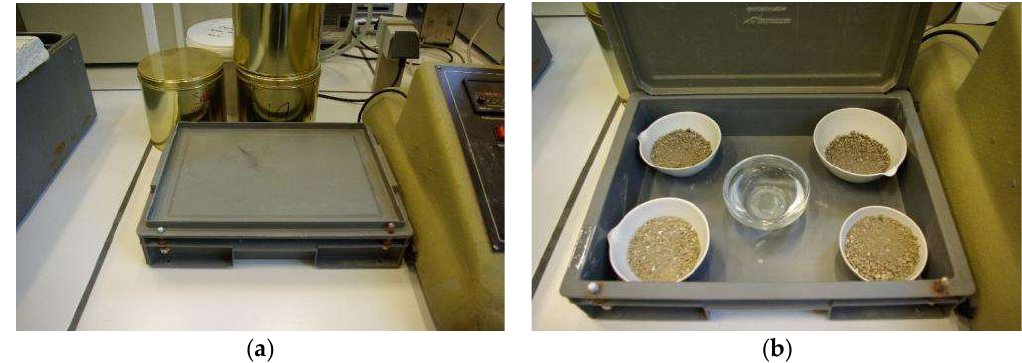
Figure 1. Experimental device for water capture measurement from atmospheric air water: ( a ) closed box in the laboratory with temperature and humidity set at 20 ± 3 °C and 60 ± 10%; and ( b ) the closed box containing the dried samples and water.